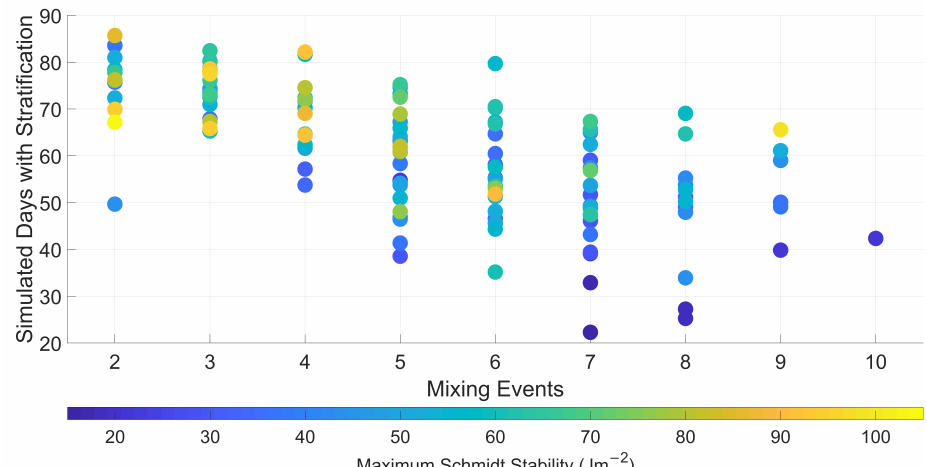
Figure 10. Comparison of mixing events and number of simulated days where stratification was present, where S is above the threshold. The scatter plot colour scheme depicts the maximum daily S from the model runs varying from minimum (cooler, blue tones; minimum of 15 Jm − 2 ) to maximum (warmer, yellow tones; maximum of 105 Jm − 2